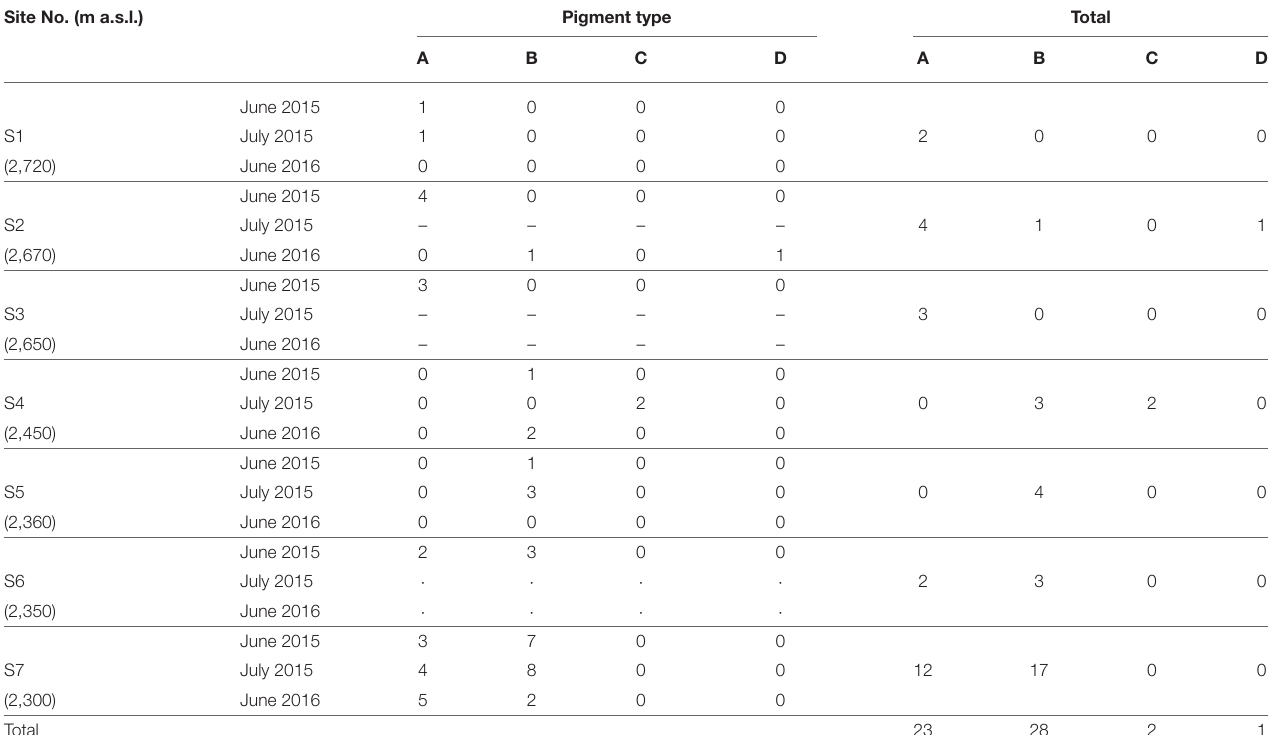
TABLE 2 | Number of samples classified into four pigment types at each study site and month. Site No. (m